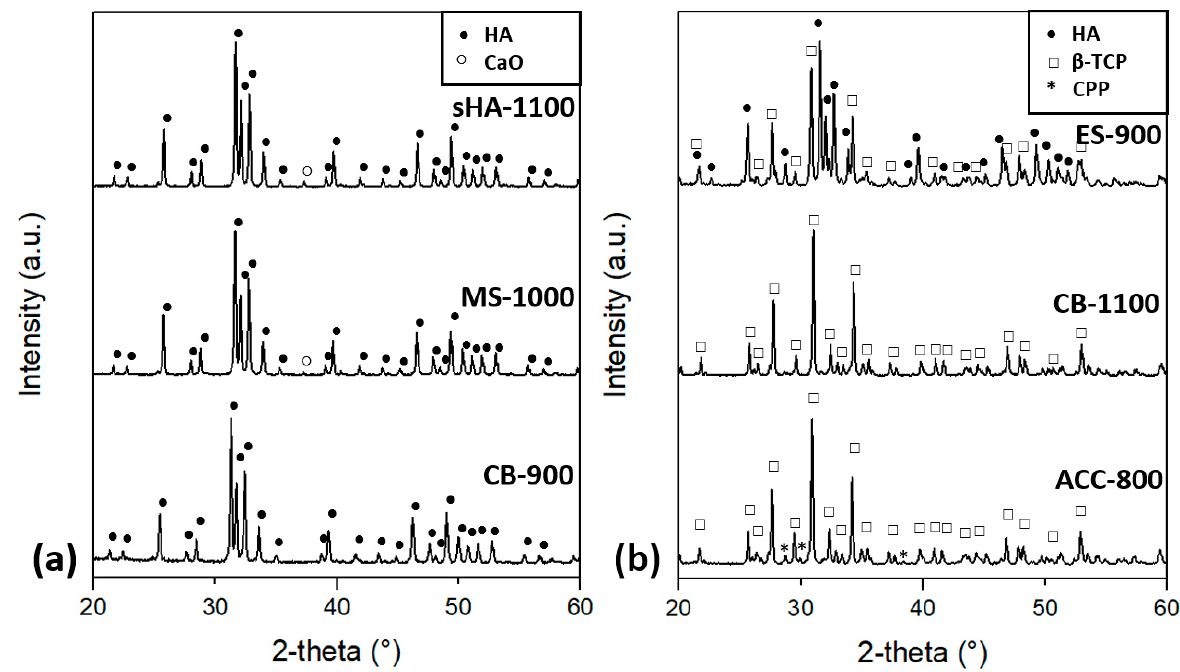
Figure 2. XRD spectra of the sintered pellets: ( a ) sHA-1100, MS-1000 and CB-900; ( b ) ES-900, CB-1100 and ACC-800. Table 3. The concentration of the fundamental elements and Ca/P molar ratio in the raw materials (CaCO 3 ) and synthesized powders (HA) as determined by inductively coupled plasma/optical emission spectroscopy (ICP/OES)